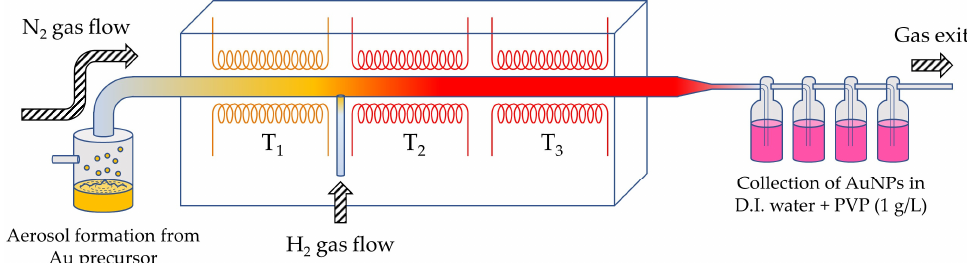
Figure 1. A schematic presentation of the ultrasonic spray pyrolysis (USP) device used for the synthesis of gold nanoparticles (AuNPs).